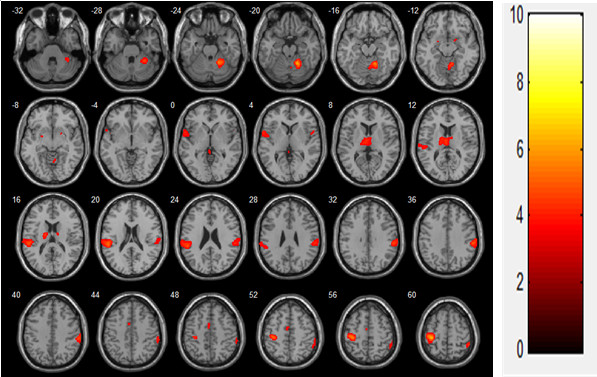
 FES-induced stimulation (N = 19, t(18) > 3.116, FDR < 0.05).